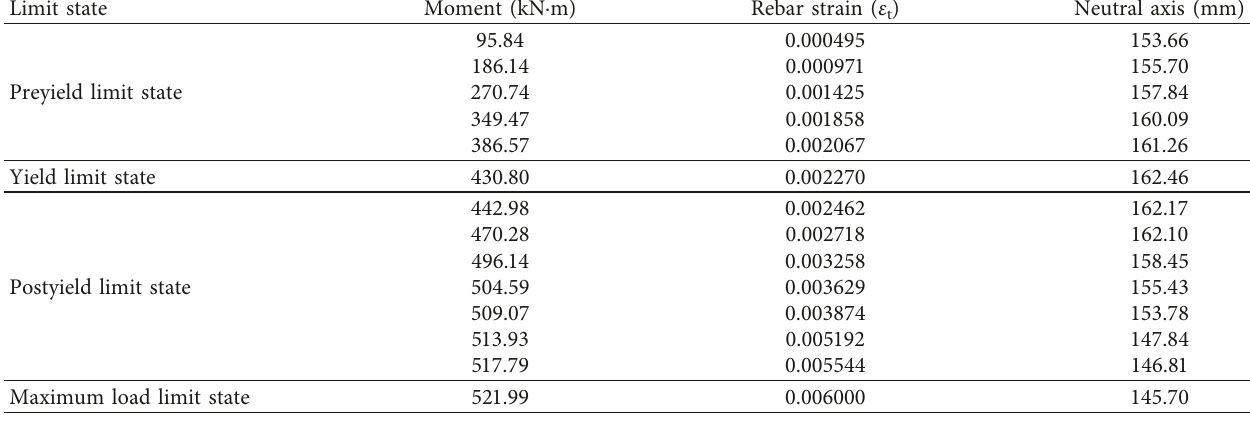
Table 11: Analytical moment-strain relationship (Specimen #3) [19].